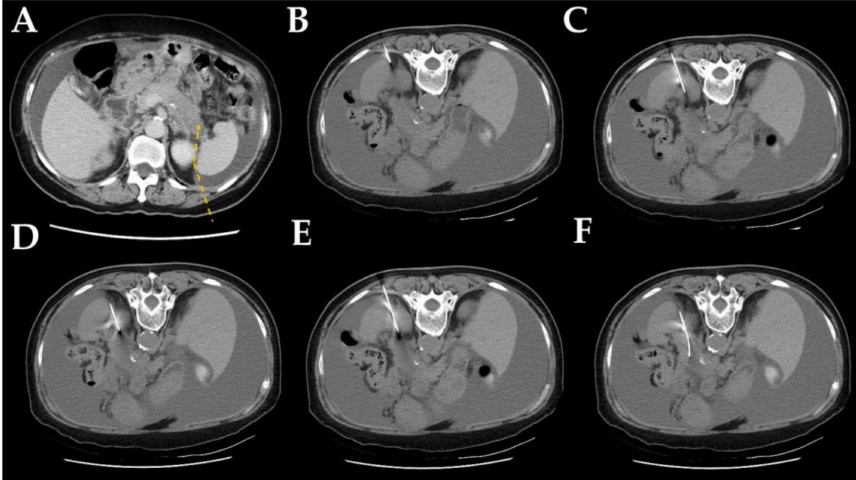
Figure A3. CT-guided core needle biopsy images via detour route